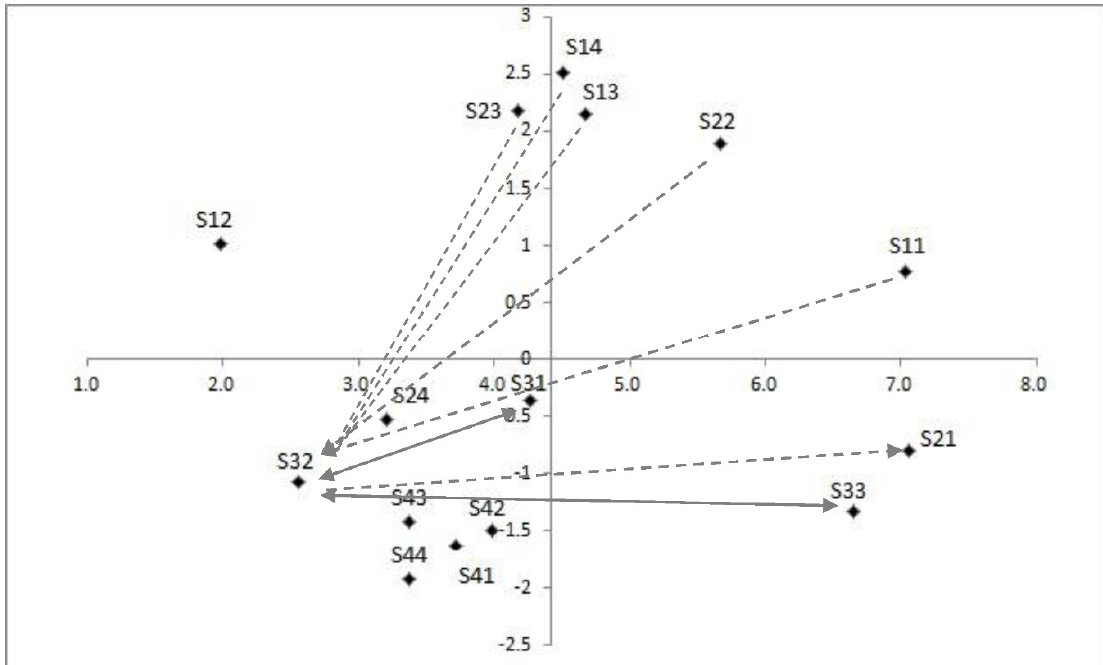
Figure A10. Casual Diagram between S32 and Other